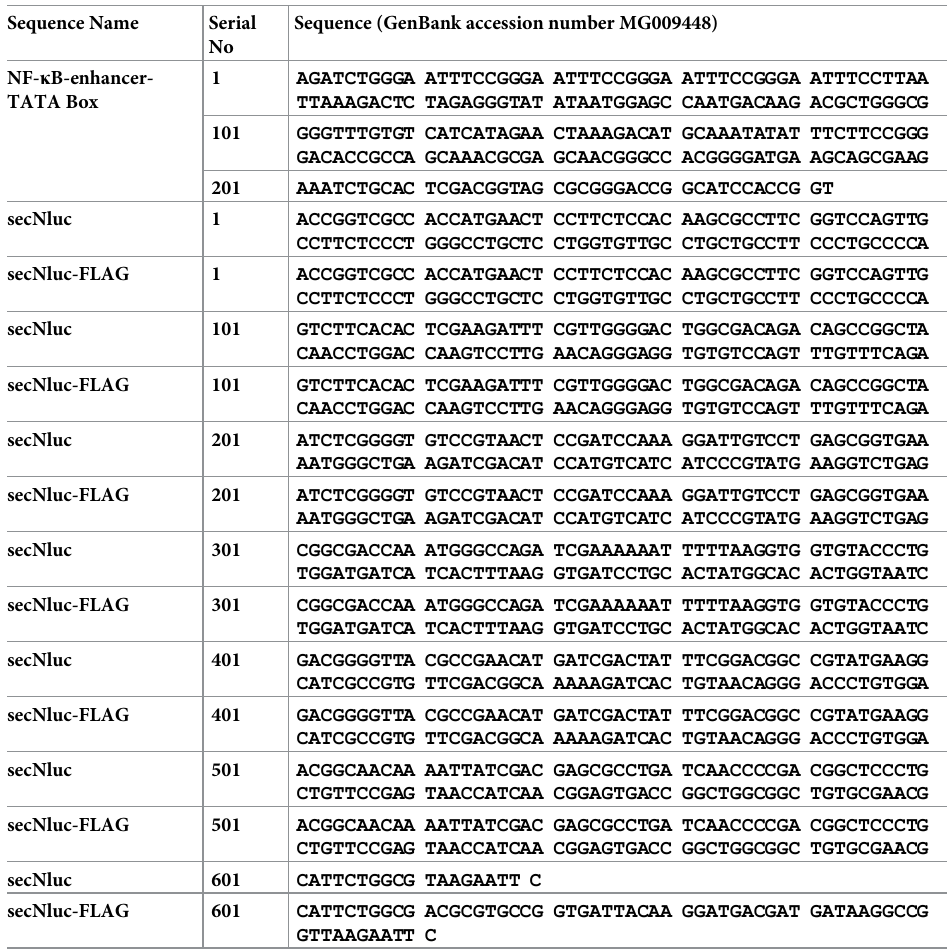
Table 1. Sequences of the NF- κ B-TATA box, secNluc and secNluc-FLAG. (NF- κ B-enhancer-TATA Box: Bgl IIis 1 to 6; Age I is 237 to 242. secNluc-FLAG: Age I is 1 to 6; secNluc is 7 to 610; FLAG-Taq is 611 to 652; Terminator is 653 to 655; EcoR I is 656 to